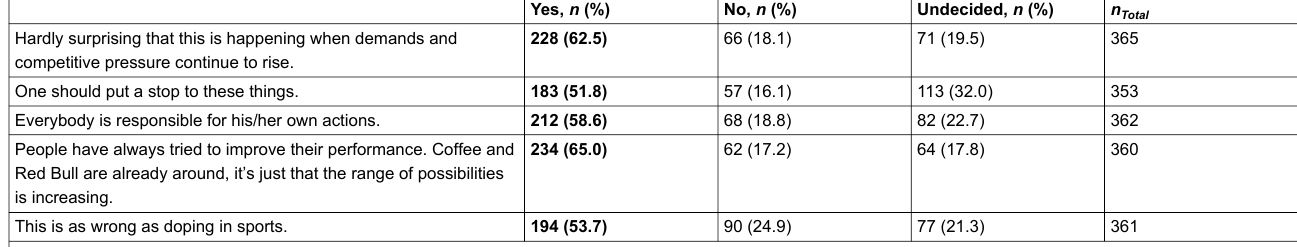
Table 1: Which of the following statements come(s) closest to your own spontaneous reaction to the increasing use of performance enhancing drugs (multiple answers possible)? Yes, n (%) No, n (%) Undecided, n (%) n Total